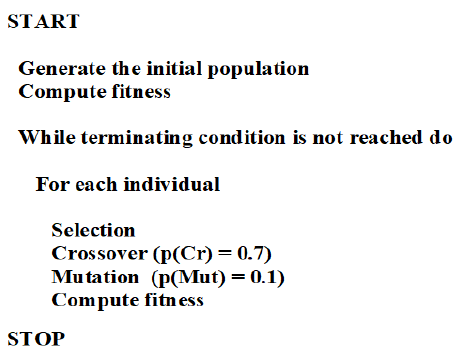
Figure 4. Pseudocode of genetic algorithm considered.